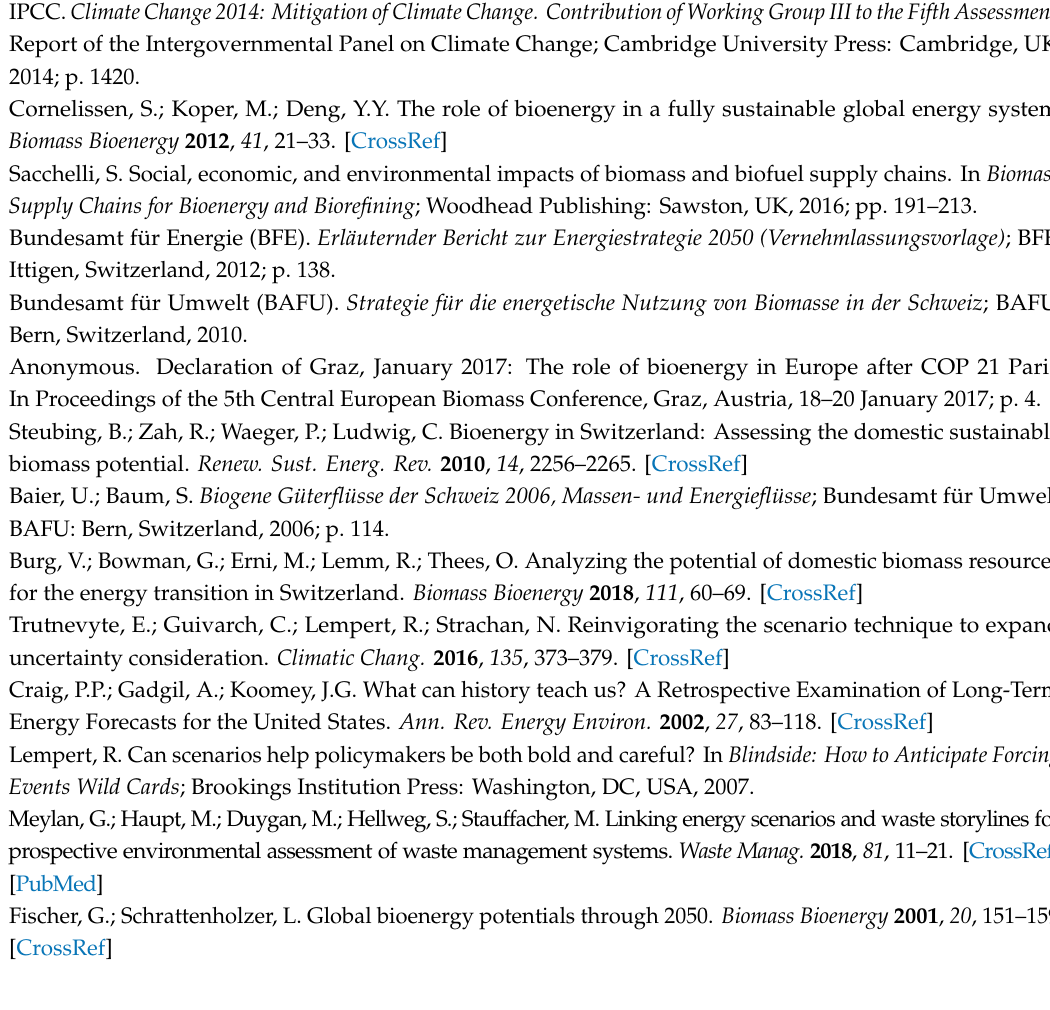
runs. Table S1: Animal manure—Correlation coe ffi cient and level of significance of tested variables. Table S2: Agricultural crop by-products—Correlation coe ffi cient and level of significance of all tested variables. Table S3: Org. fraction of household garbage & green waste from household and landscape—Correlation coe ffi cient and level of significance of all tested variables. Table S4: Commercial and industrial organic waste—Correlation coe ffi cient and level of significance of all tested variables. Table S5: Time series from 1996 to 2016. Table S6: Time series projections for 2035 and 2050 from the ARIMA model Table S7: Future biomass availability for 2035 and 2050 as theoretical and sustainable potentials in primary energy in